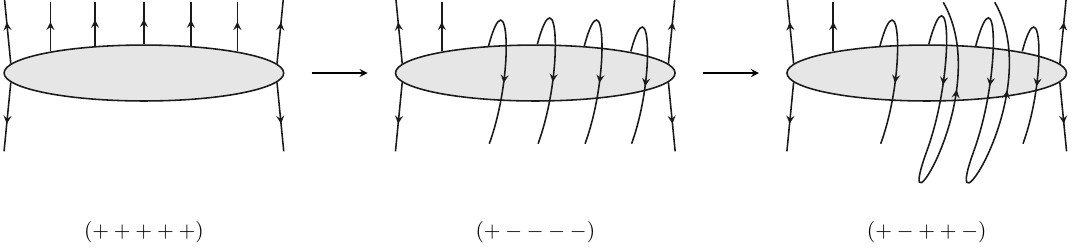
Figure 9 . Graphical representation of the analytic continuation to the Mandelstam region in which the three-Reggeon bound state is expected to contribute to the nine-point remainder